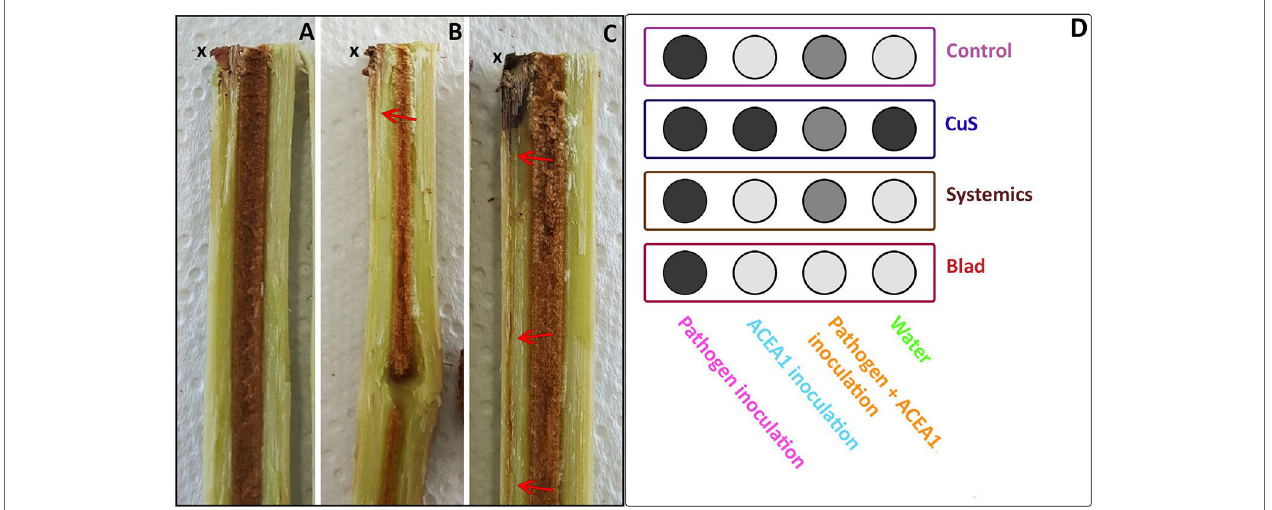
FIGURE 2 | Grapevine rooted cuttings were examined, revealing different degrees of brown wood streaking symptomatology. Category 1, absence of symptoms (A) departing from the inoculation point (x) downwards; Category 2, presence of mild symptomatology (B) ; Category 3, extensive symptomatology (C) . (D) Each category is presented in a different scale of gray, as an average of the observations for each treatment/inoculum ( n = 3), where Category 1 is shown in light gray, Category 2 in gray, and Category 3 in dark